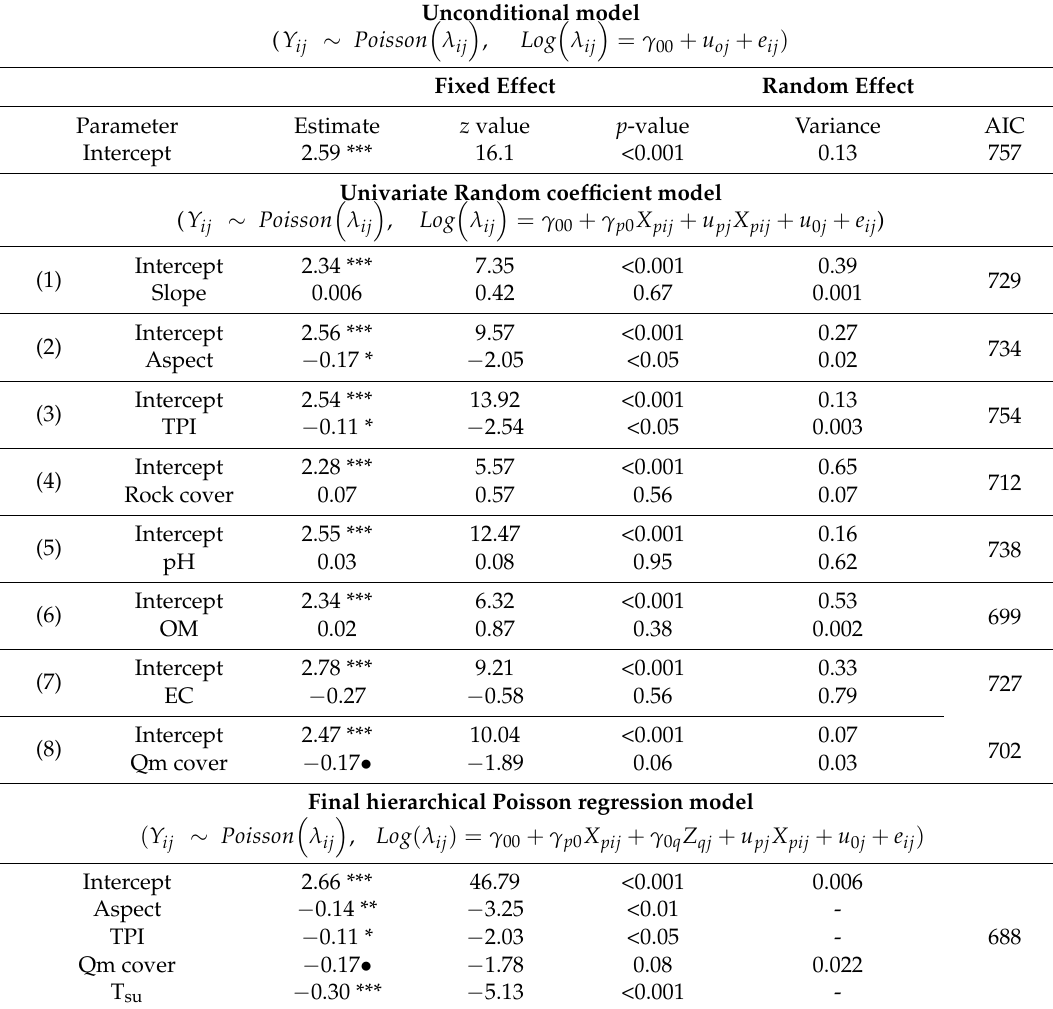
(cid:17) (cid:16) Z j